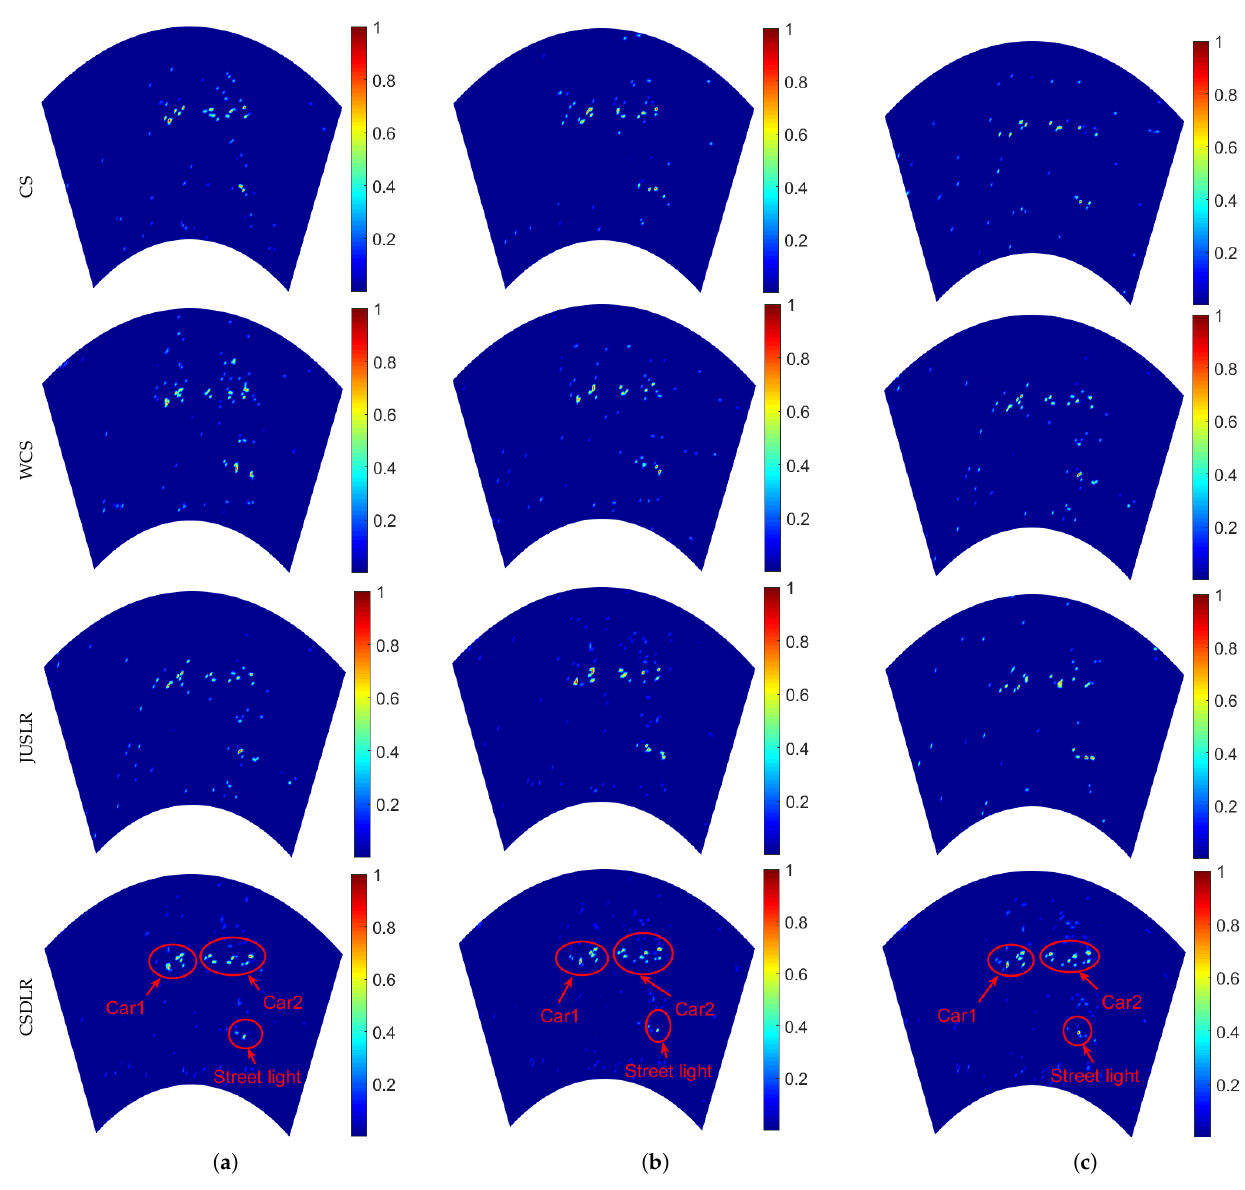
Figure 13. Comparison of imaging results of different methods in measured data experiment.